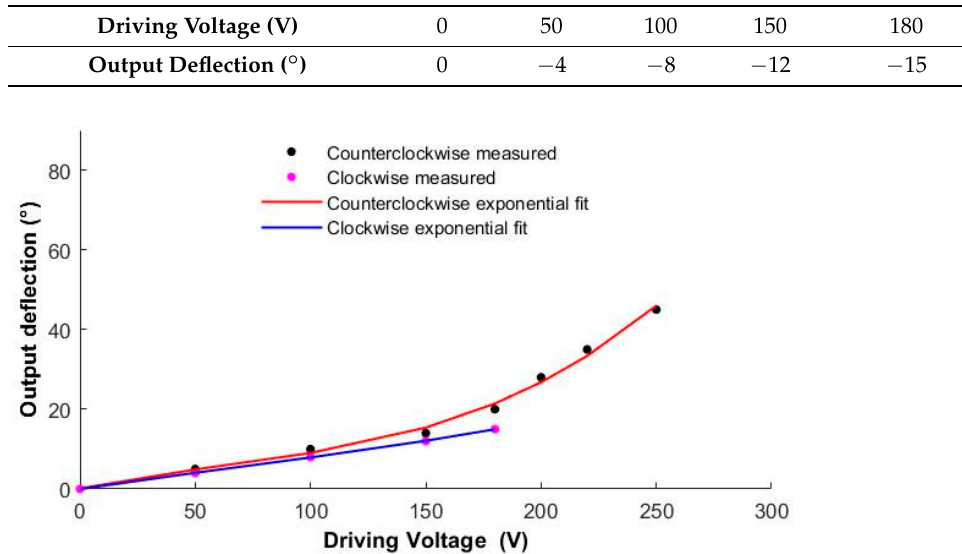
Figure 10. Output bias angle versus forward-biased and reverse-biased drive signals.